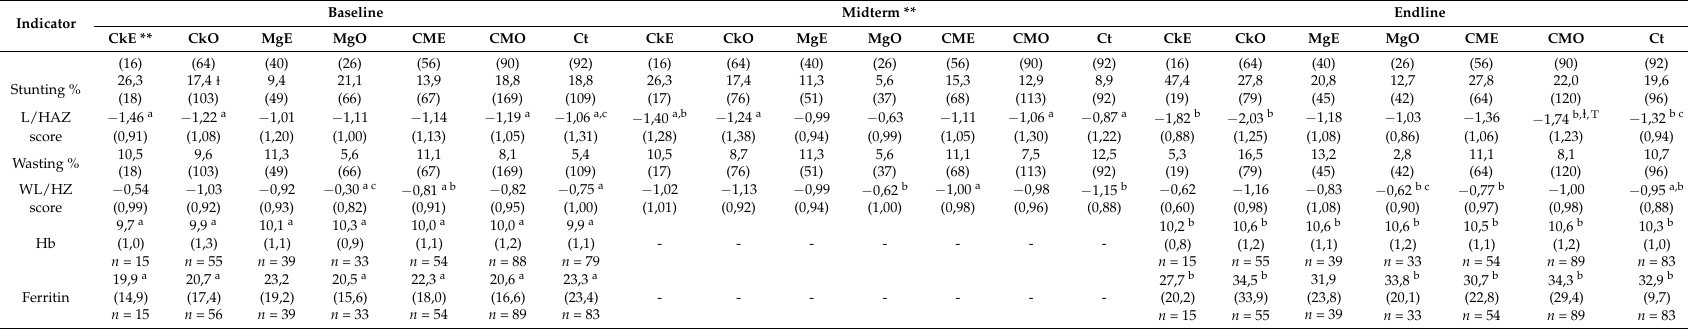
Table 2. Nutritional status of sub-groups of the children population involved in baseline, midterm and endline: prevalence of undernutrition (%) and mean z -score ( ± standard deviation/SD) for anthropometric and biochemical indicators *.